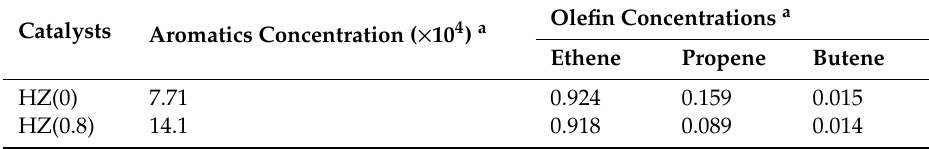
Table 5. Relative concentration of gaseous products for propane aromatization obtained in micro reactor experiment.